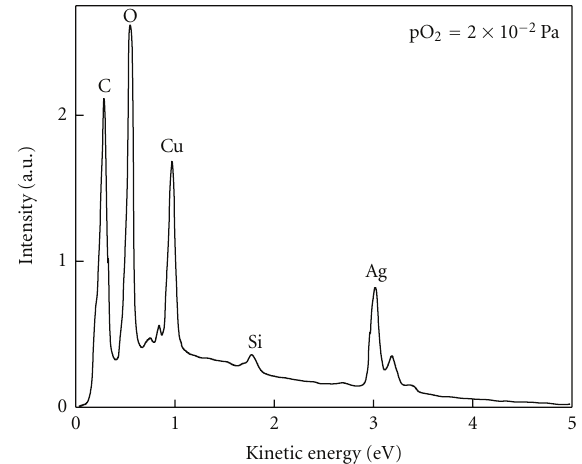
Figure 1: EDS spectrum of Ag-Cu-O film formed at an oxygen partial pressure of 2 × 10 − 2